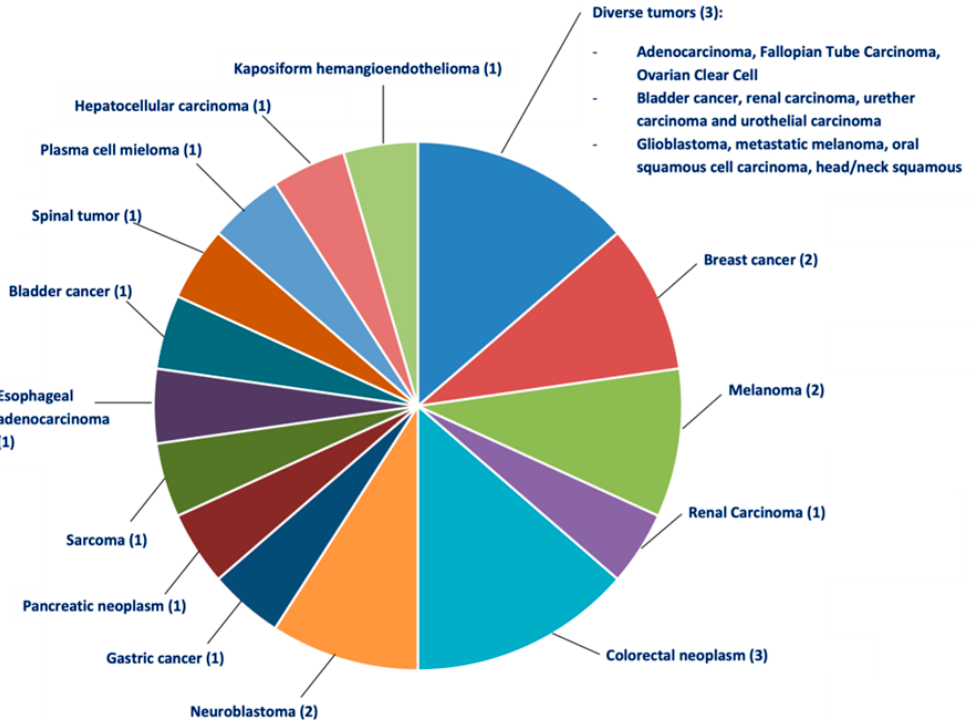
Figure 4. The distribution of the different clinical trials where propranolol has been used in combinatorial treatment therapies. In this case propranolol has been combined with different chemotherapeutic compounds in a wide range of diverse oncological processes. In brackets, the number of tests performed.